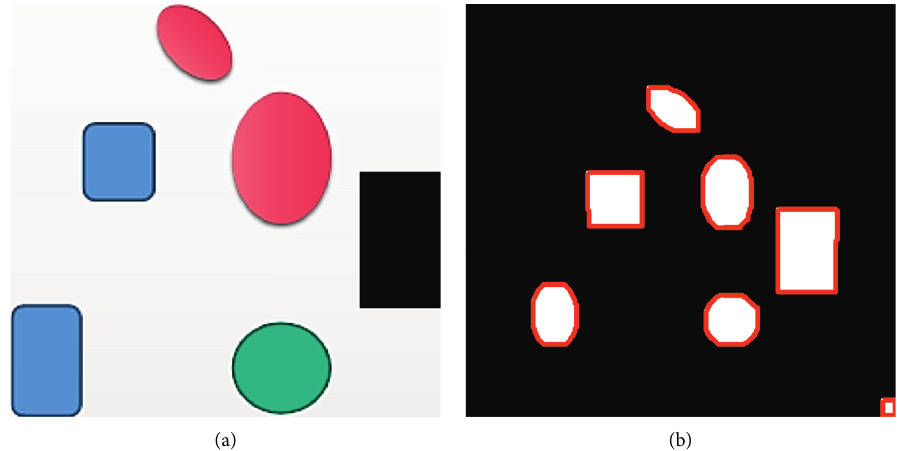
Figure 9: Image situation before and after artificial intelligence recognition. (a) Before. (b) After.